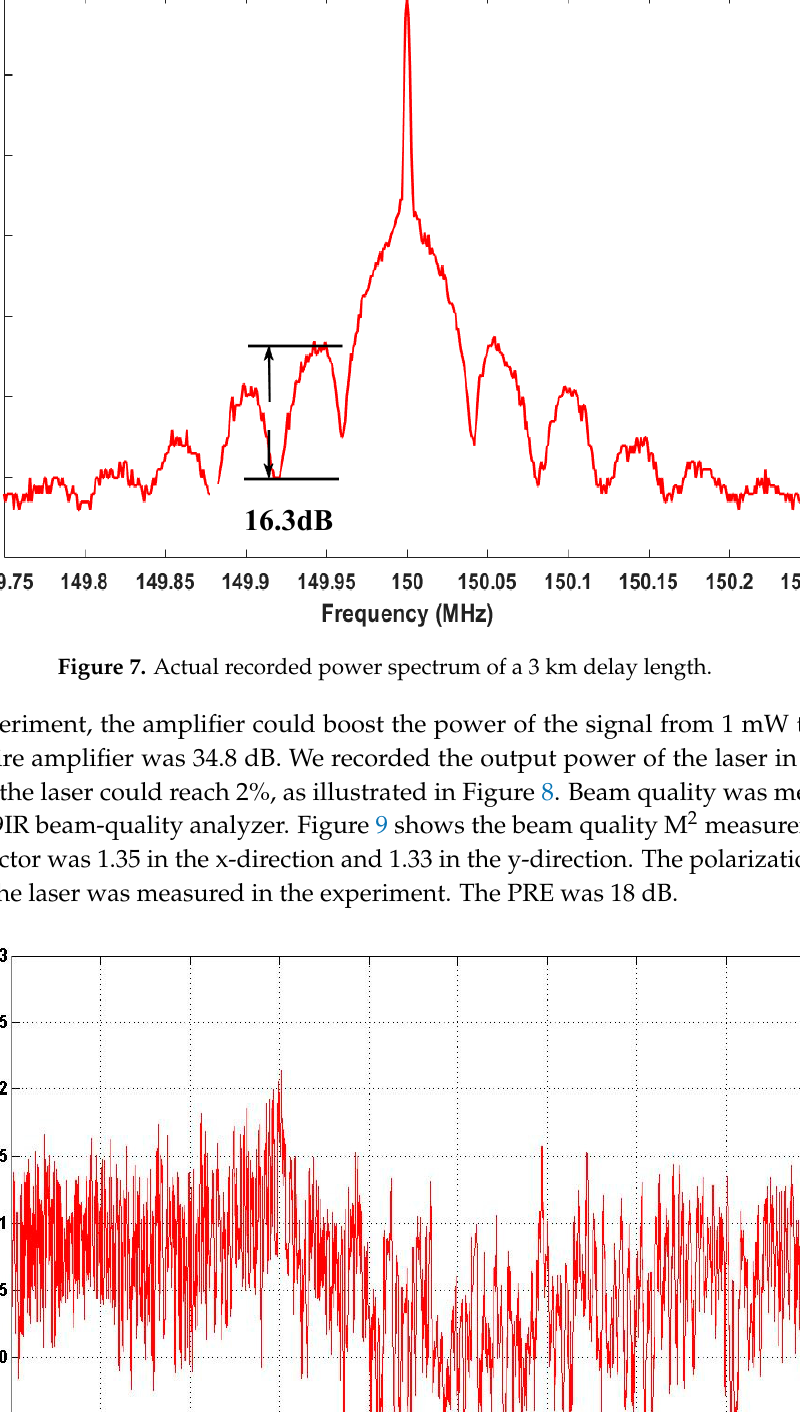
Figure 6. Output spectrum and power spectrum of 25 km delayed self-heterodyne of 20 W laser signal. ( a ) Shows the output spectrum of the power amplifier at the maximum output power. ( b ) Shows the actual recorded power spectrum at the maximum output power of laser measured with 25 km delayed fiber.